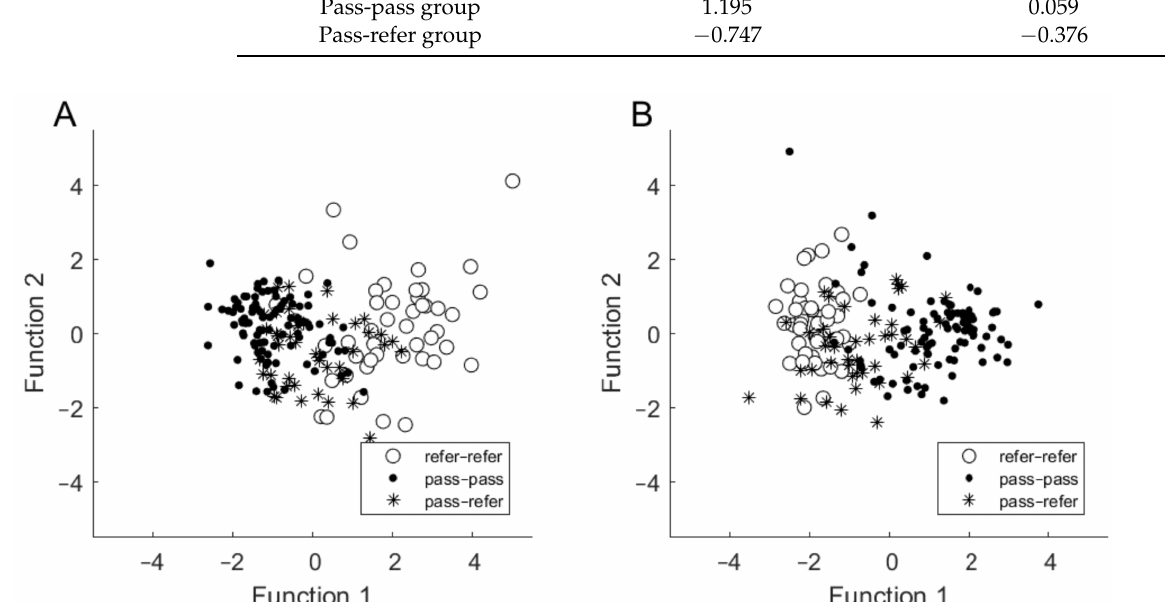
Figure 2. Discriminant function plots in which discrimination is based on hearing thresholds ( A ) and on SNR ( B